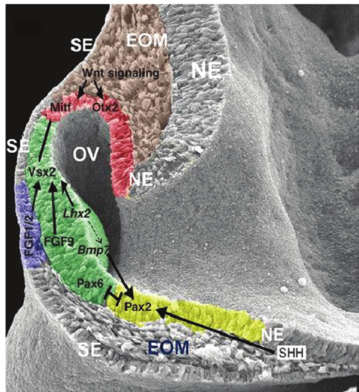
Figure 1: Crucial biomolecules expression in an embryonic mouse at 9.5 days. The neural ectoderm (NE) bulges as optic vesicle (OV) to reach the surface ectoderm (SE) on both sides. The SE became thicker upon the contact of NE to become the lens placode. Except in the lens placode region, the NE and SE are separated by the EOM. In the NE, the presumptive RPE, neural retina, and optic tract are colored red, green, and yellow, respectively. The lens placode is colored blue. The TF reciprocally act to regulate eye development. EOM,extraocularmesenchyme;RPE,retinalpigmentedepithelium; NR,neuralretina;TF,transcriptionfactor.Copyright2012.Modified with permission from Cold Spring Harbor Laboratory Press